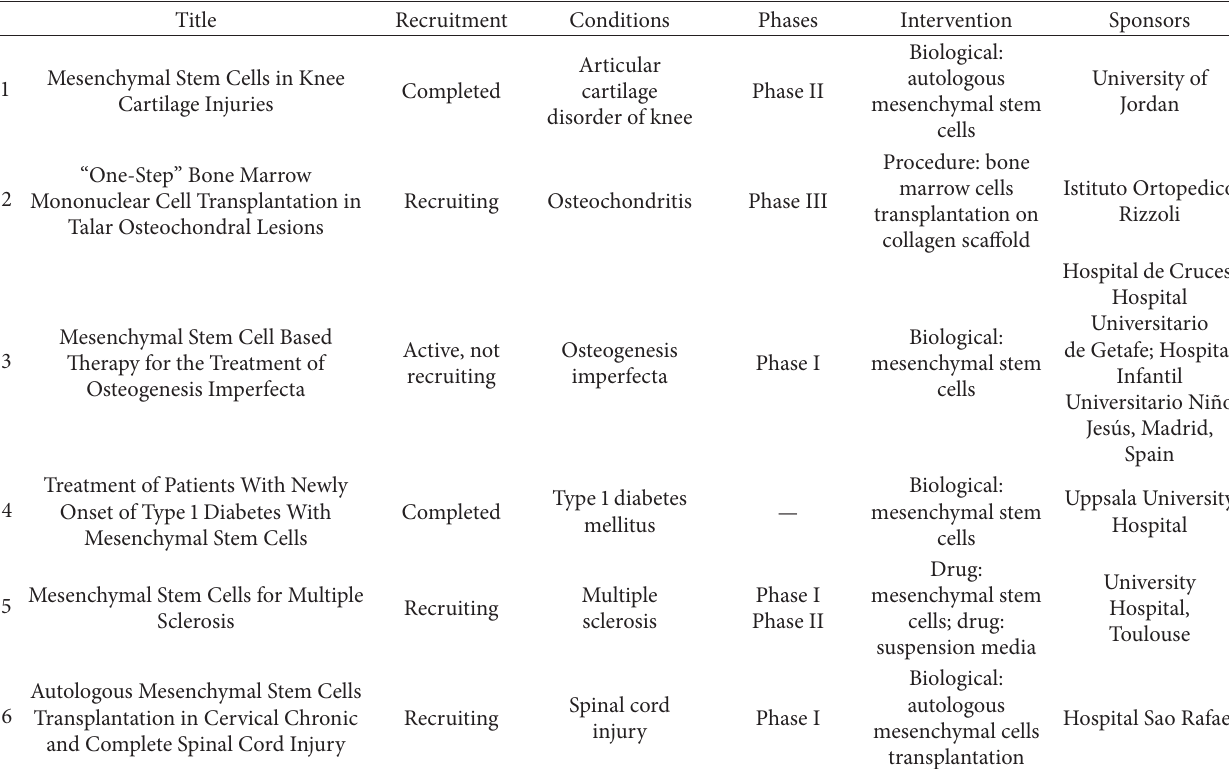
Table 1: A selection of registered clinical trials on the basis of MSC as the relevant therapeutic tool (https://www.clinicaltrials.gov).